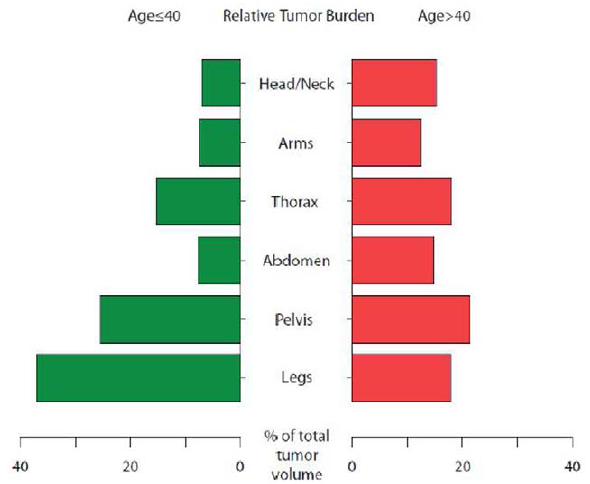
Figure 5. Relative tumor burden of patients younger and older than 40. Patients older than 40 are represented in red; patients 40 or younger are shown in green. These two patient subpopulations differed significantly in relative tumor burden along the craniocaudal axis (p=0 ? 003 by permutation test) with patients 40 or younger having a higher percentage of tumor volume in the pelvis and legs than patients over 40.